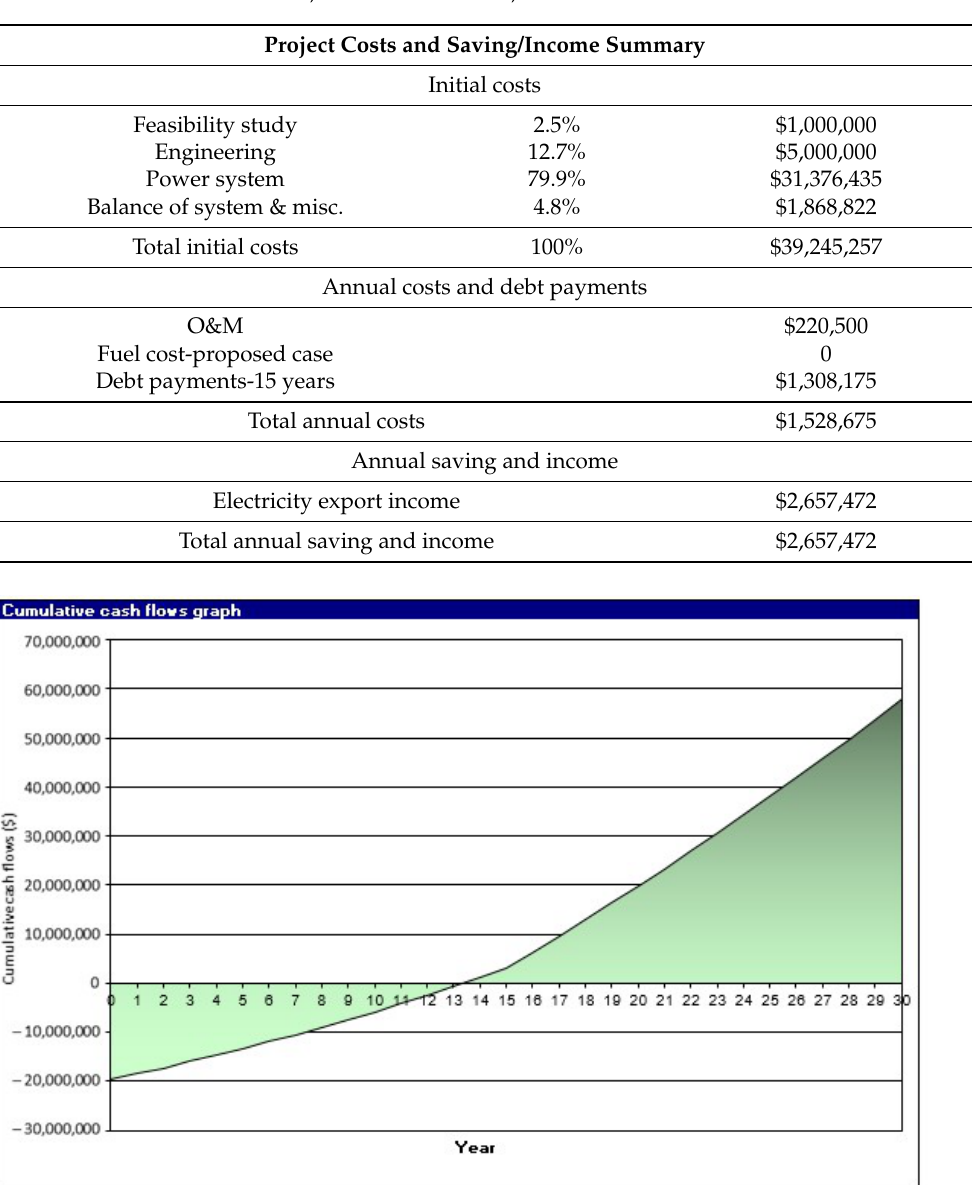
Table 6. Initial and annual costs, and annual income, for Scenario 1.